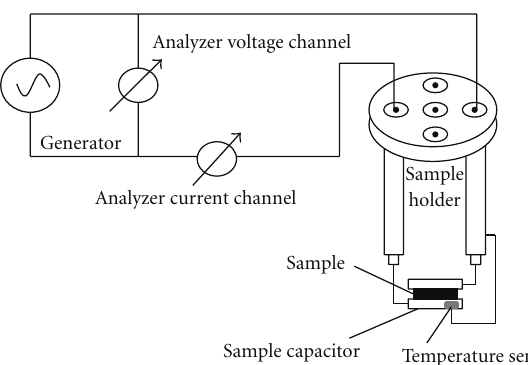
Figure 3: Cell used to measure the ionic conductivity of the mem- branes.